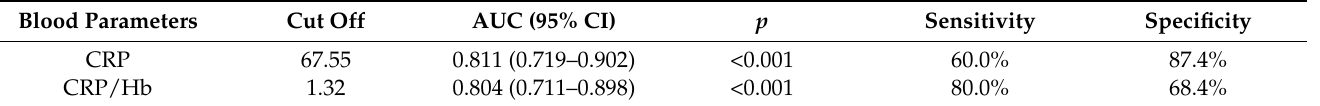
Table 4. ROC curve results for blood parameters in the